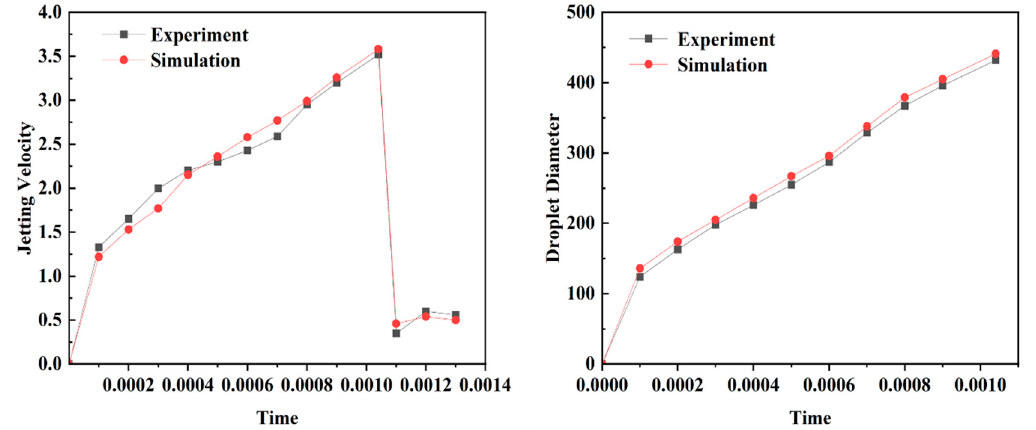
Figure 12. Experimental and simulation comparison of jetting velocity and droplet diameter for case 27.